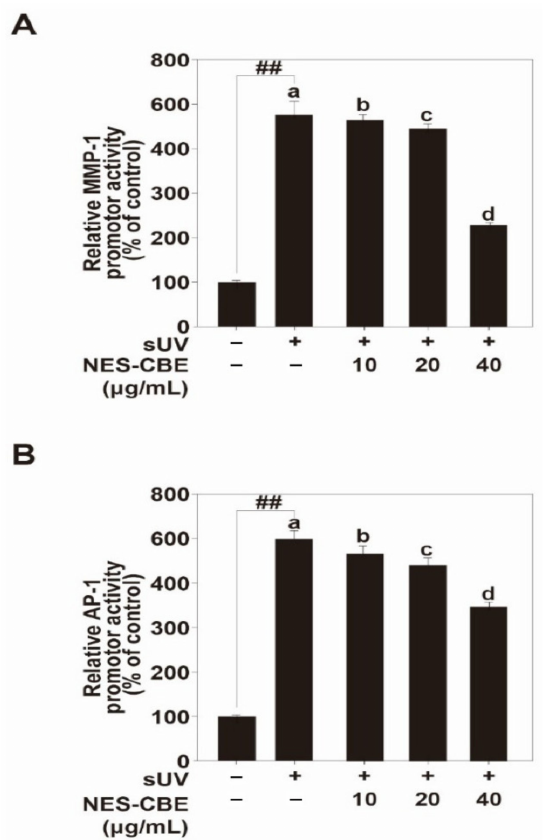
Figure 3. NES-CBE suppresses sUV-induced MMP-1 transcription by inhibiting AP-1 transactivation. ( A ) Effect of NES-CBE on sUV-induced MMP-1 promotor activity. MMP-1 promoter reporter